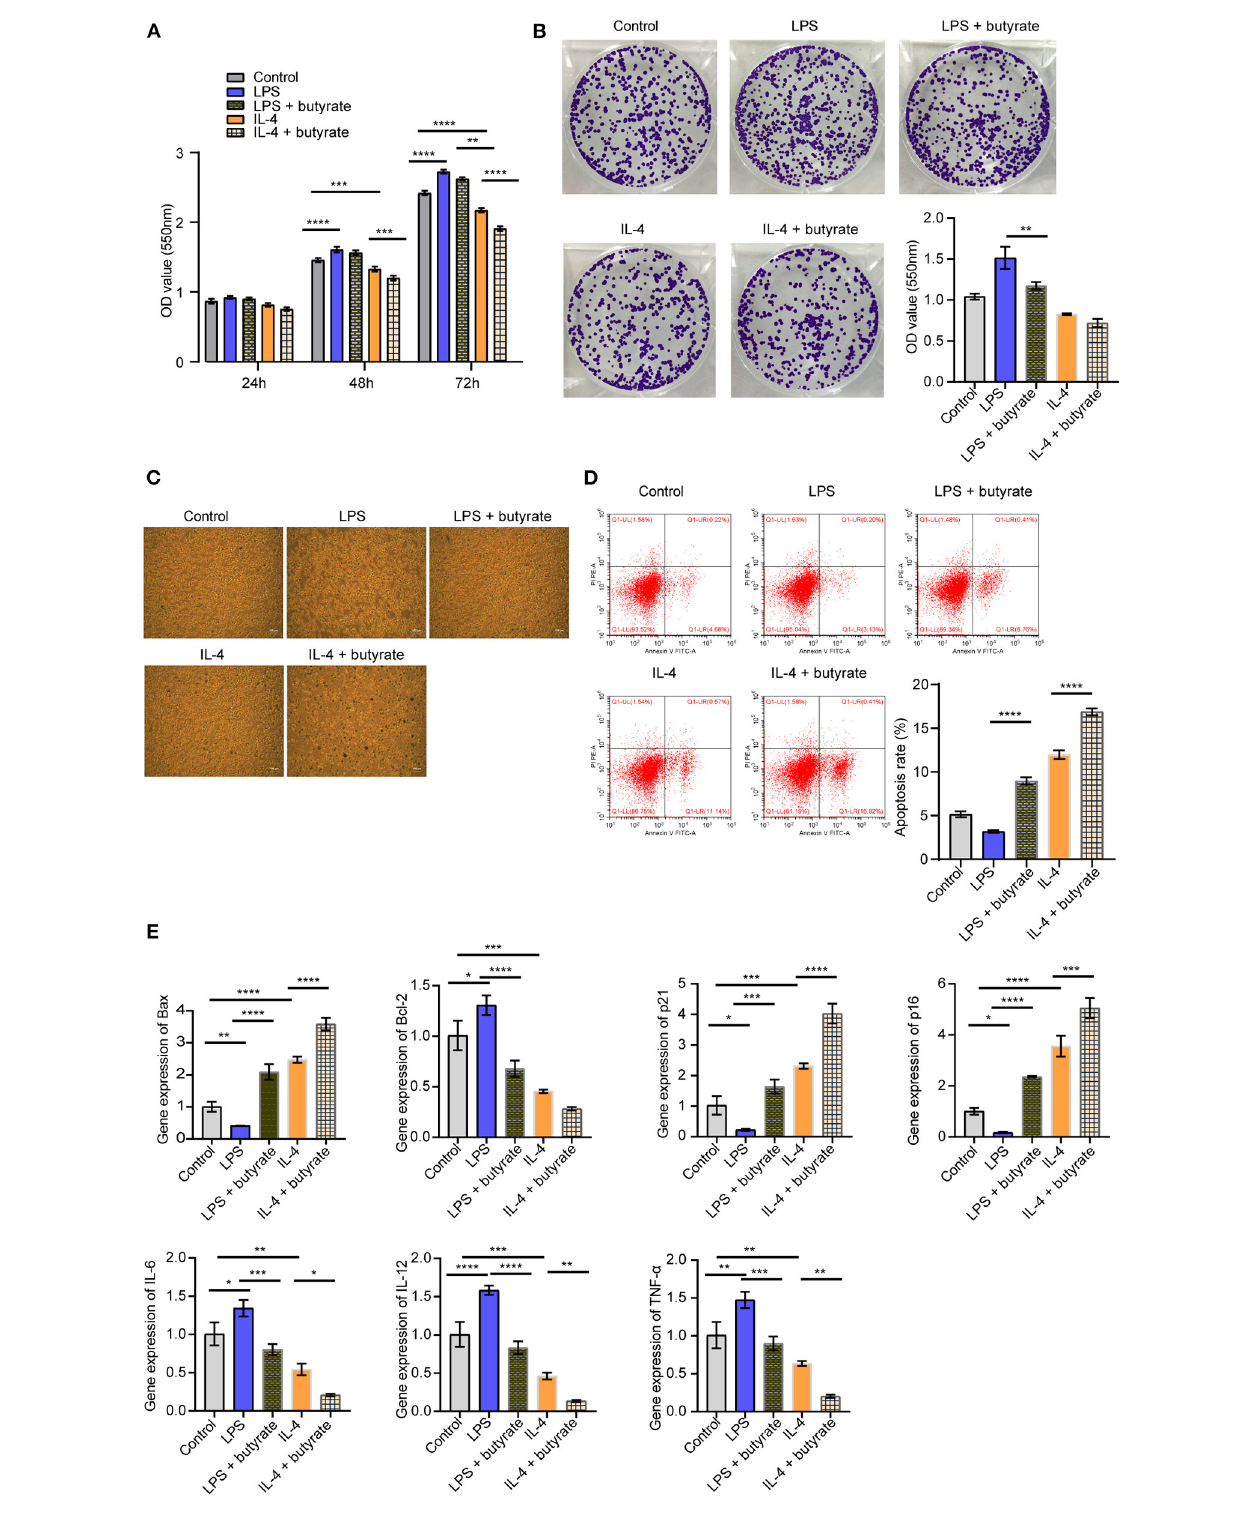
FIGURE 5 | Butyrate inhibited rat myocardial fibroblasts activity. (A) CCK-8 was applied to detect cell proliferation. (B) Cell proliferation was detected by clone formation assay. (C) SA- β -Gal staining was used to detect cell senescence. (D) Flow cytometry was used to detect apoptosis. (E) The expression of apoptosis, senescence signaling pathway and inflammatory factors (Bax, Bcl-2, p21, p16, IL-6, IL-12, and TNF- α ) was measured by qRT-PCR. * P < 0.05, ** P < 0.01, *** P < 0.001, **** P < 0.0001.